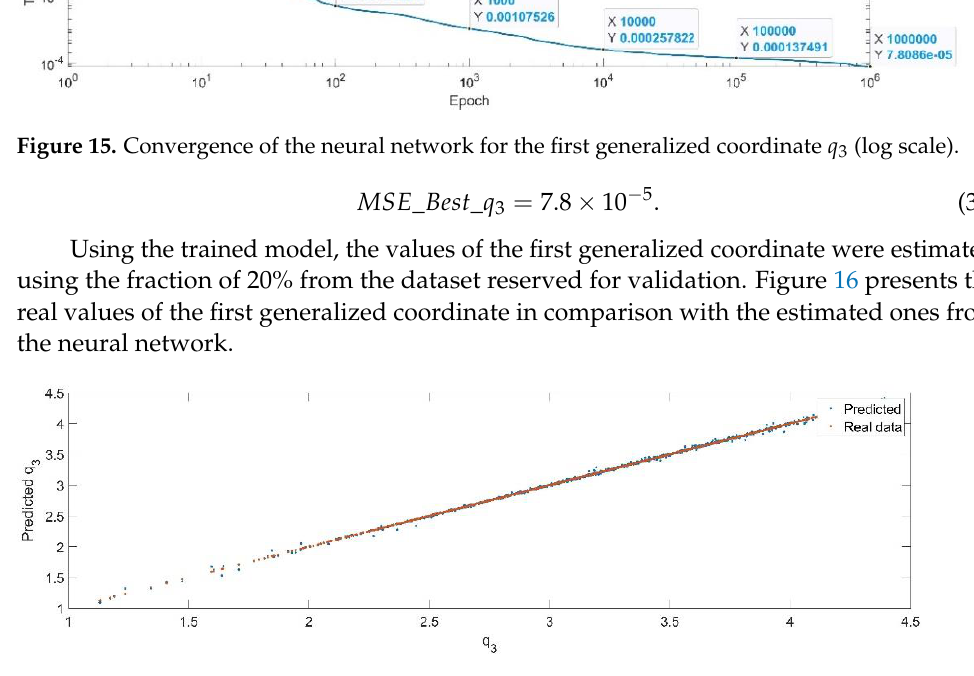
Figure 16. The comparison between the real data (the real value of 𝑞 3 ) and the predicted data (the predicted value of 𝑞 3 ).